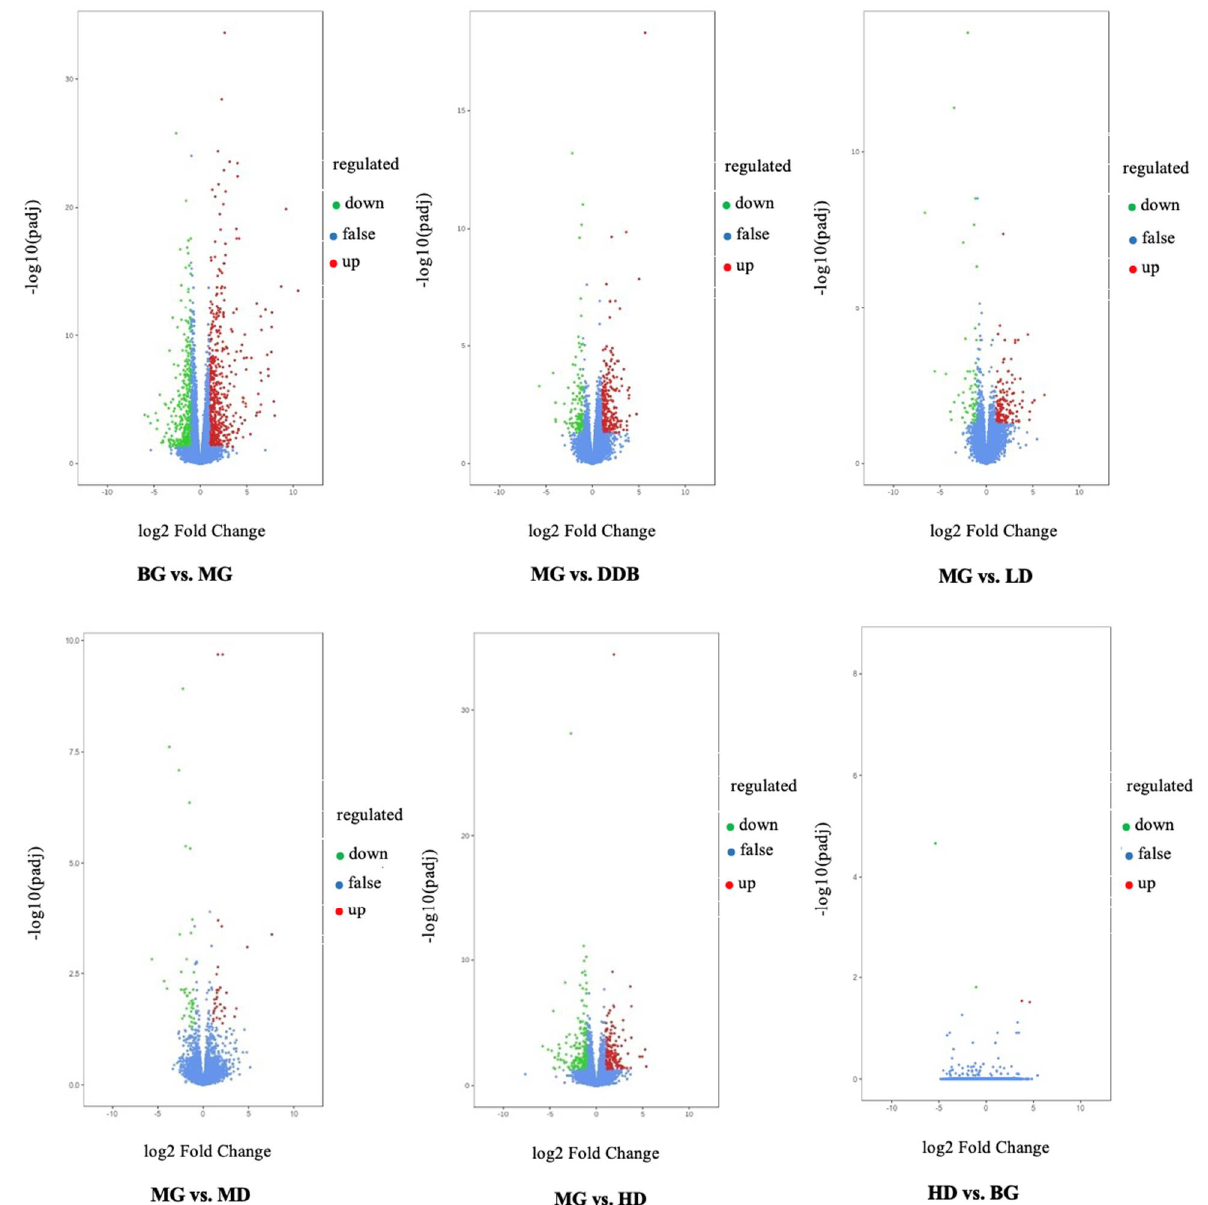
Figure 10. Volcano. Fold change in gene expression and significance level of the differential gene are plotted on the x- and y-axis, respectively. Up-regulated genes are represented by red dots, down-regulated genes are represented by green dots, and genes without differential expression are represented by blue dots.